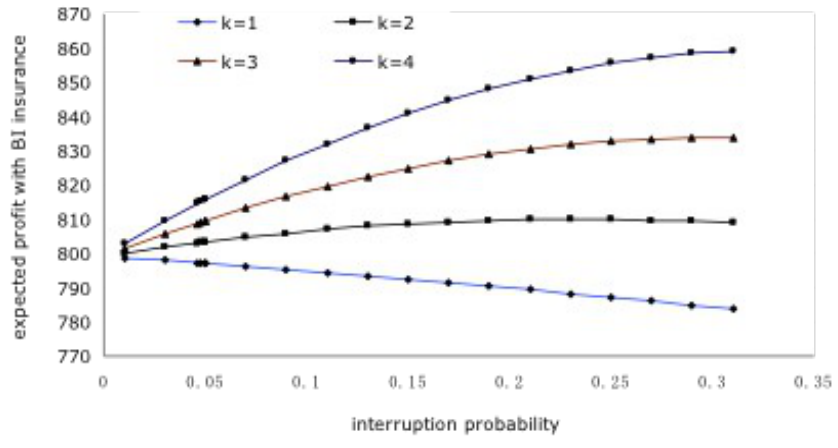
Figure 3. Analysis of BI insurance value with different